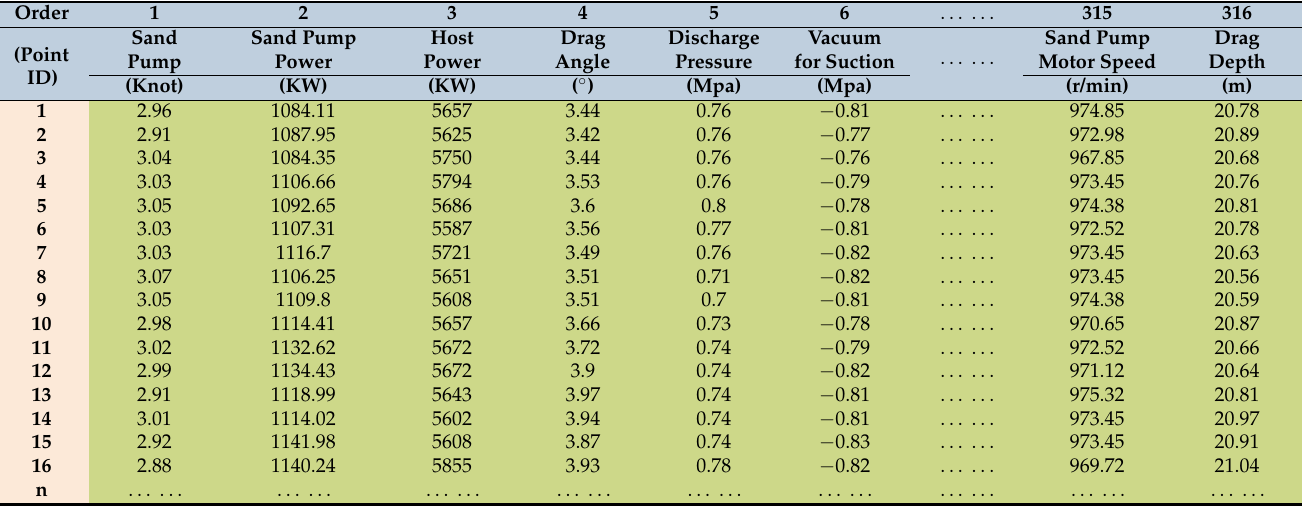
Table 1. Monitoring